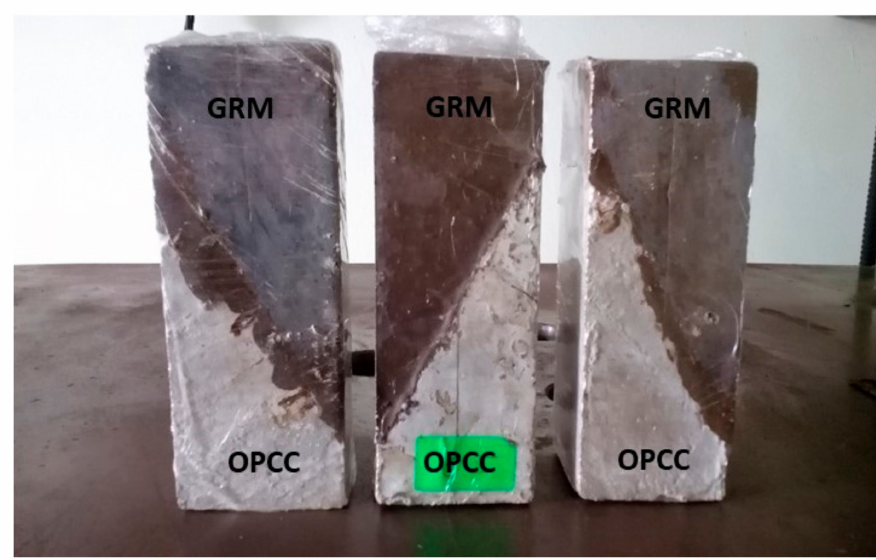
Figure 4. Samples for the slant shear test. The experiment setup for the slant shear test is presented in Figure